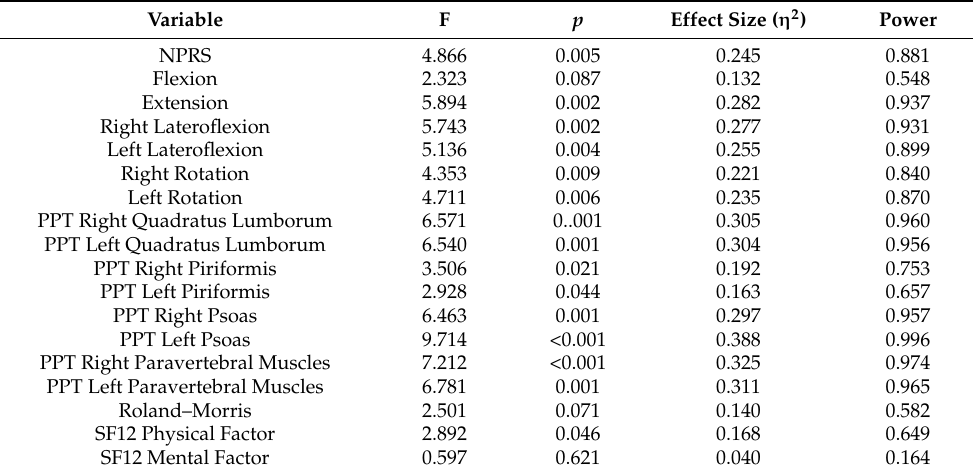
Table 2. Statistical significance, effect size and power of the time-by-group interaction from the analysis of variance.